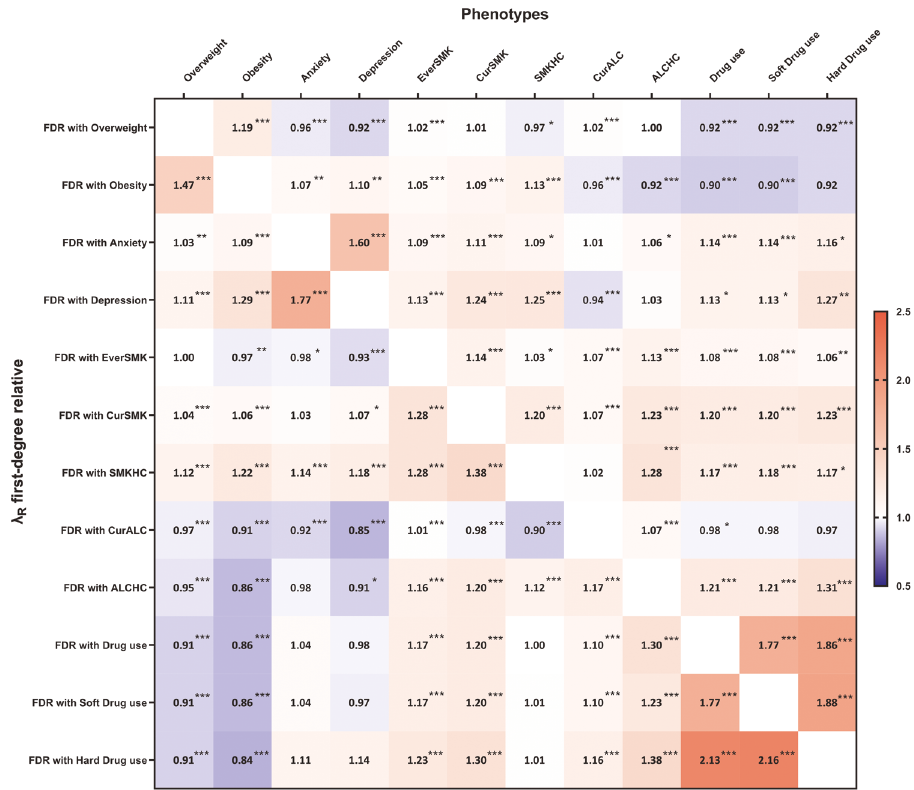
Fig. 3 Familial co-aggregation for obesity, anxiety, depression and substance use. FDR, fi rst-degree relative; EverSMK, ever smoker; CurSMK, current smoker; SMKHC, tobacco high consumption: smoking ≥ 20 cigarettes per day; CurALC, current drinker; ALCHC, alcohol high consumption: daily alcohol intake ≥ 15 grams. # λ R adjusted for age, age 2 and sex. ***p < 0.001, **p < 0.01, *p < 0.05